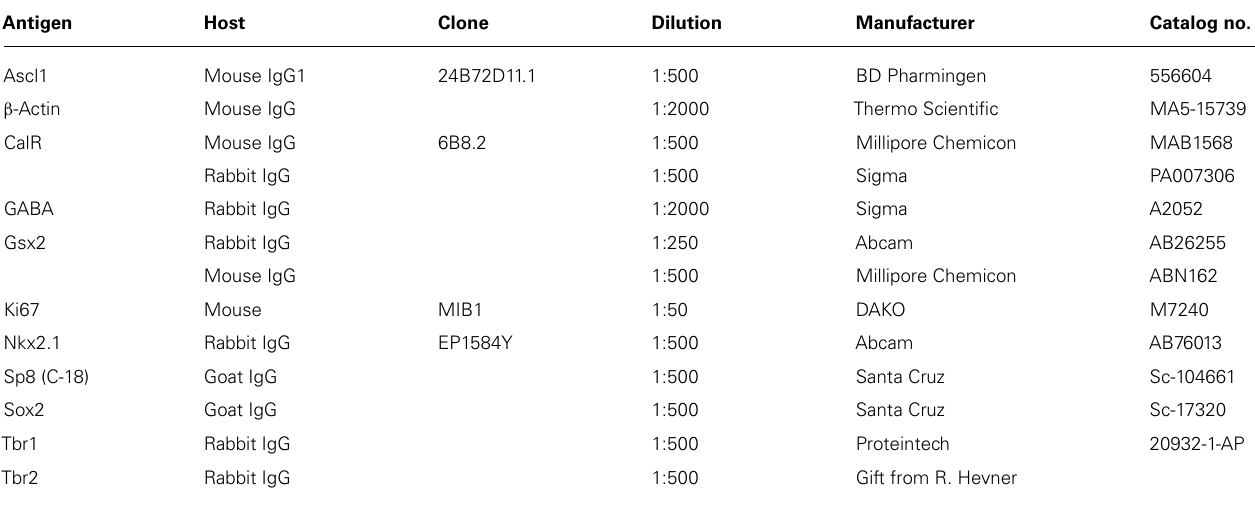
Table 2 | Primary antibodies used in this study (in alphabetical order). Antigen Host Clone Dilution Manufacturer Catalog